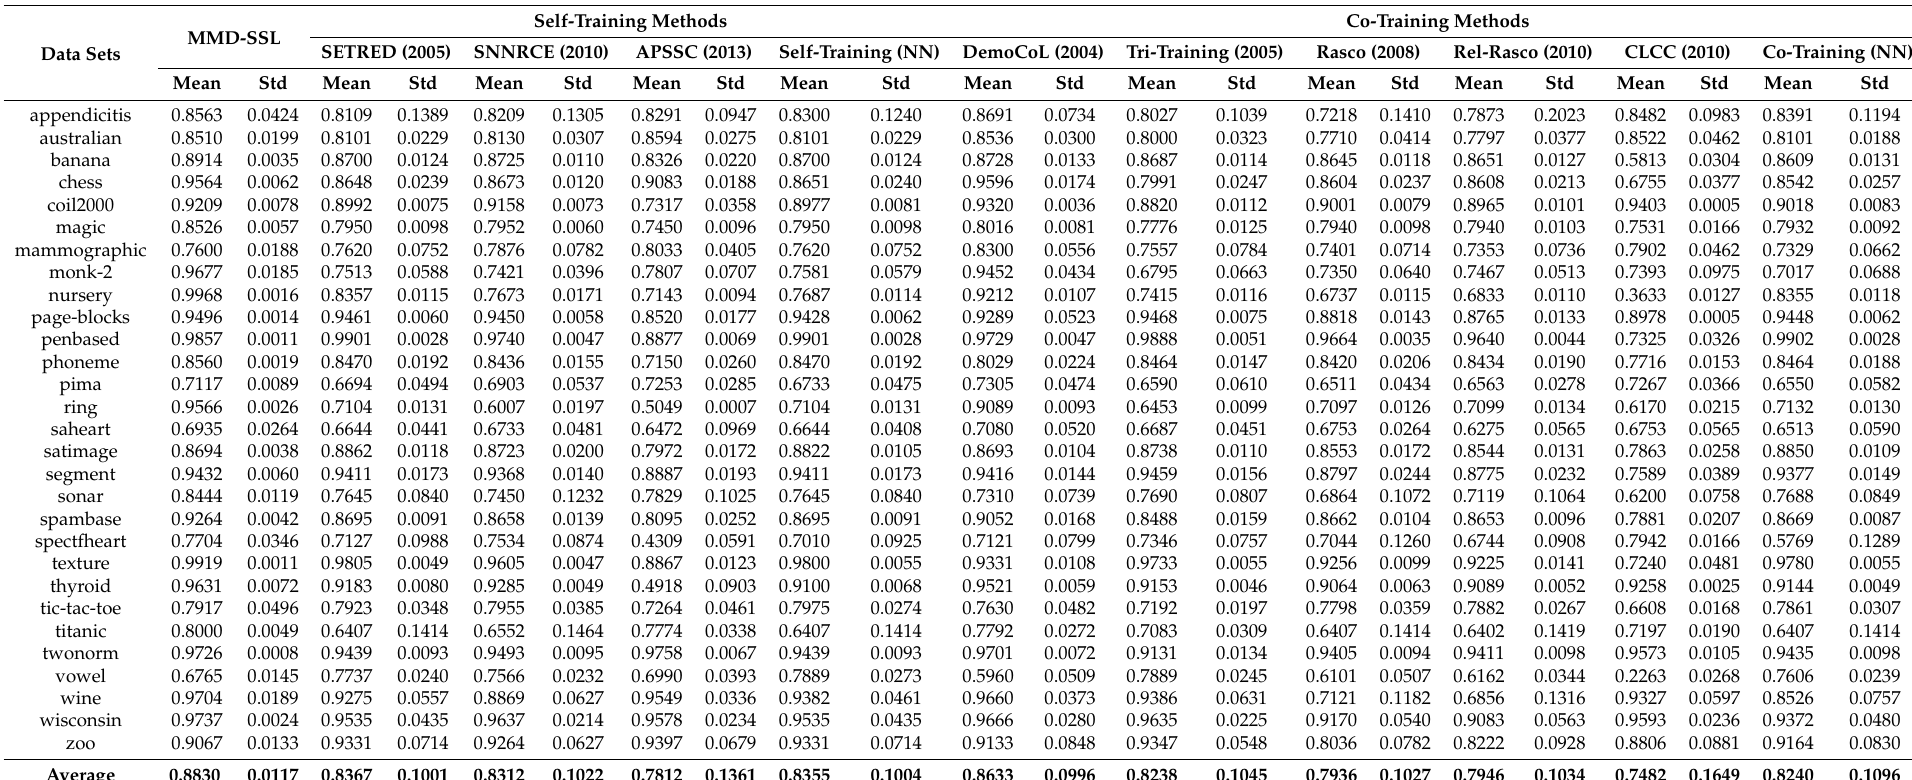
Table 4. Accuracy comparison of MMD-SSL and 10 other SSL algorithms on 30% labeled data.